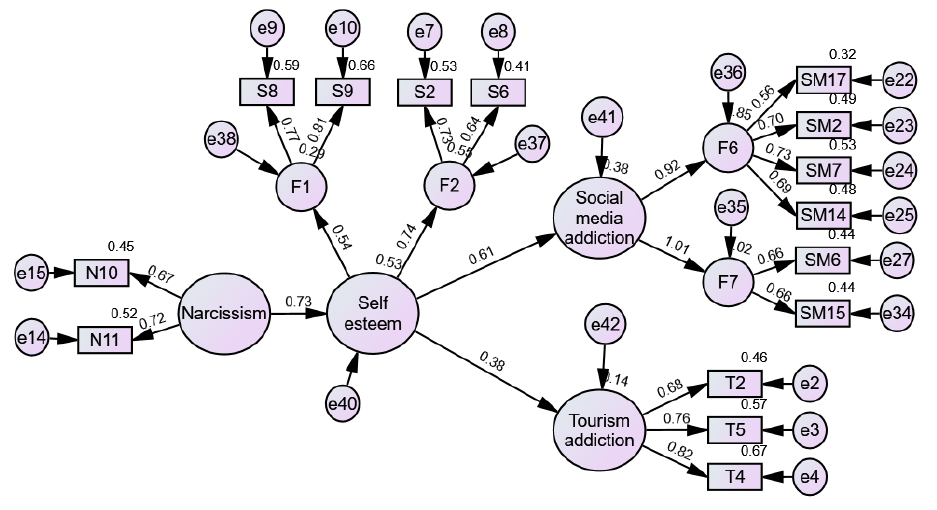
Fig. 3. Structural Model of the Second Model